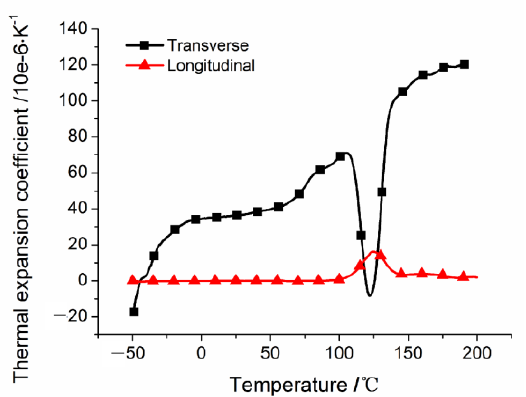
Figure 11. Resin modulus vs. ambient temperature.